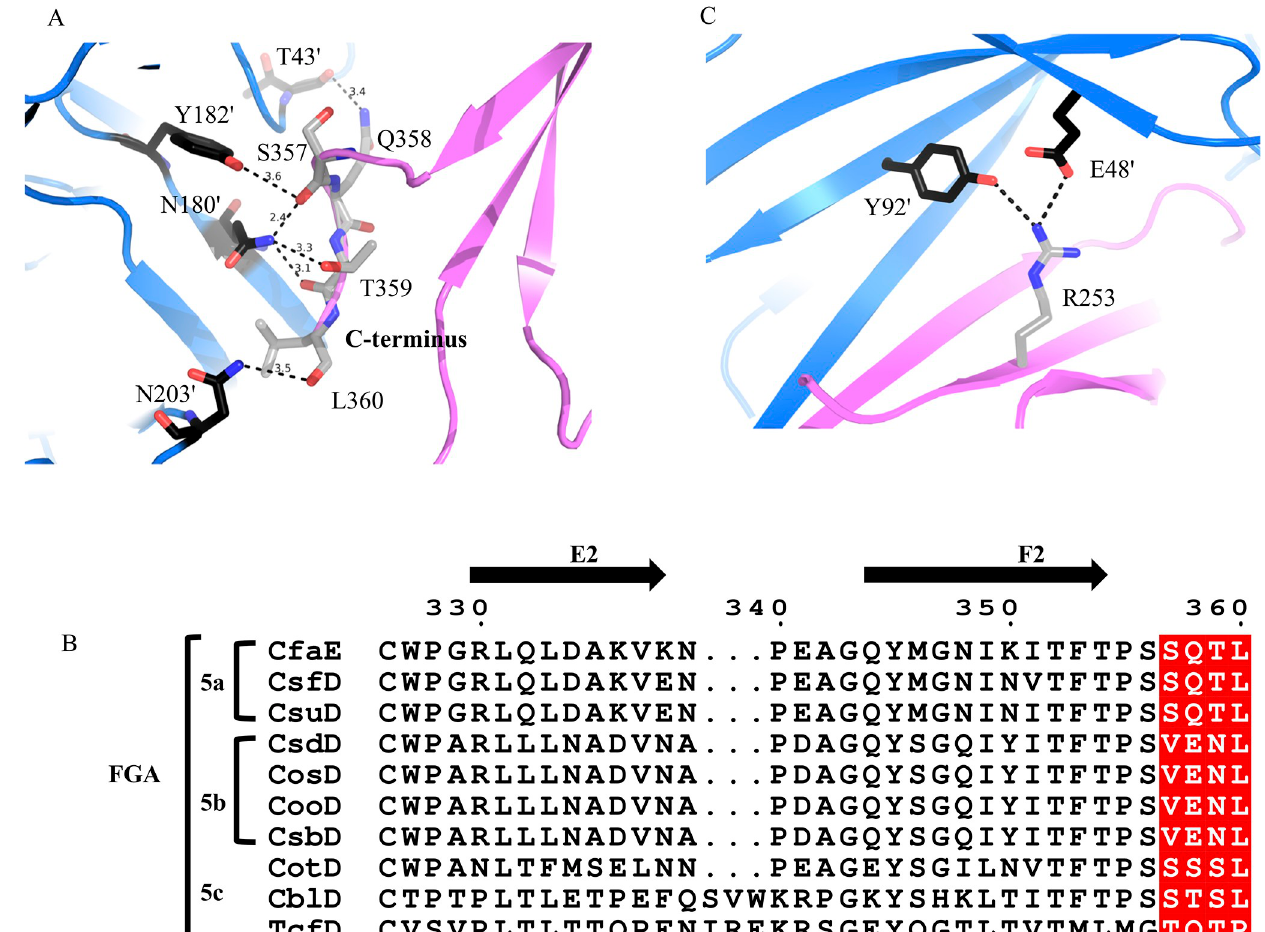
Fig 3. Unique features of mt CfaA-CfaE binary complex. (A) The last four residues (magenta) of the C-terminus of CfaE (S357, Q358, T359, L360) interact with residues (blue) in the cleft region (T43’, N180’, Y182’ and N203’) of CfaA. The residues are shown as stick models. (B) Sequence alignment of C- terminal segments from different adhesin subunits of the Class 5 fimbriae. The four C-terminal residues unique to the class are shaded red. Sequences were aligned using the program ClustalX [70], and the alignment was made using the online ESPript 3.0 server [71] (http://espript.ibcp.fr/ESPript/ESPript/). (C) Interactions of R253 (magenta) in CfaE with CfaA